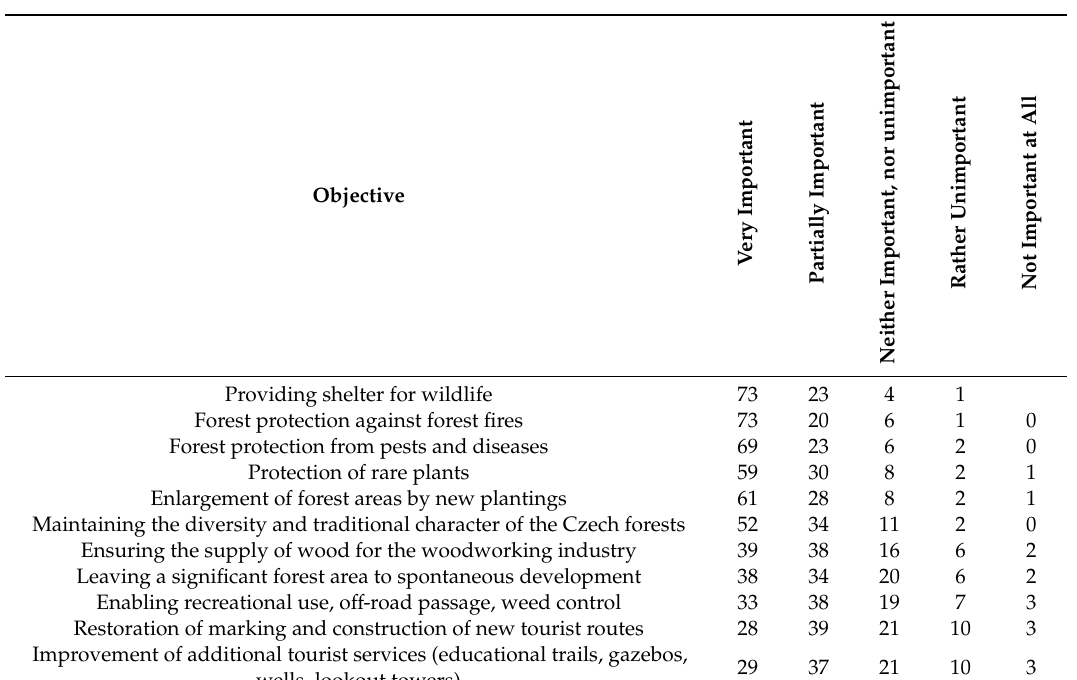
Table 4. Question: In your opinion, how important are the objectives of the forest management for society? (data in %, Source: